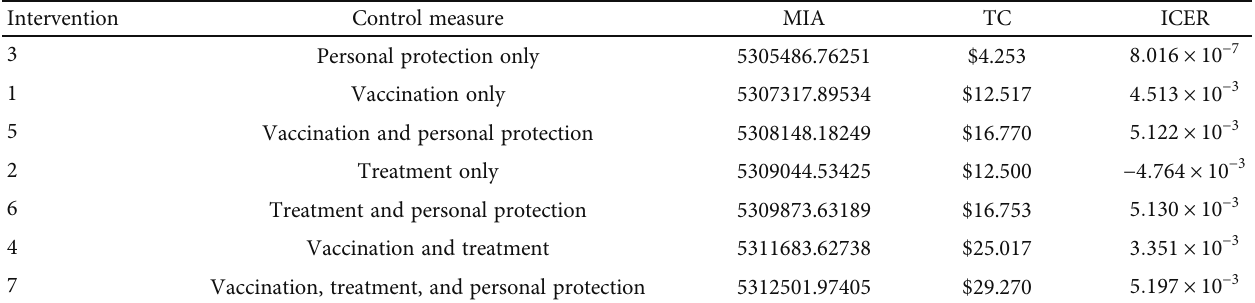
Table 6: ICER ratio based on increasing order of meningitis infection averted (MIA) and its associated cost (TC) for each intervention.